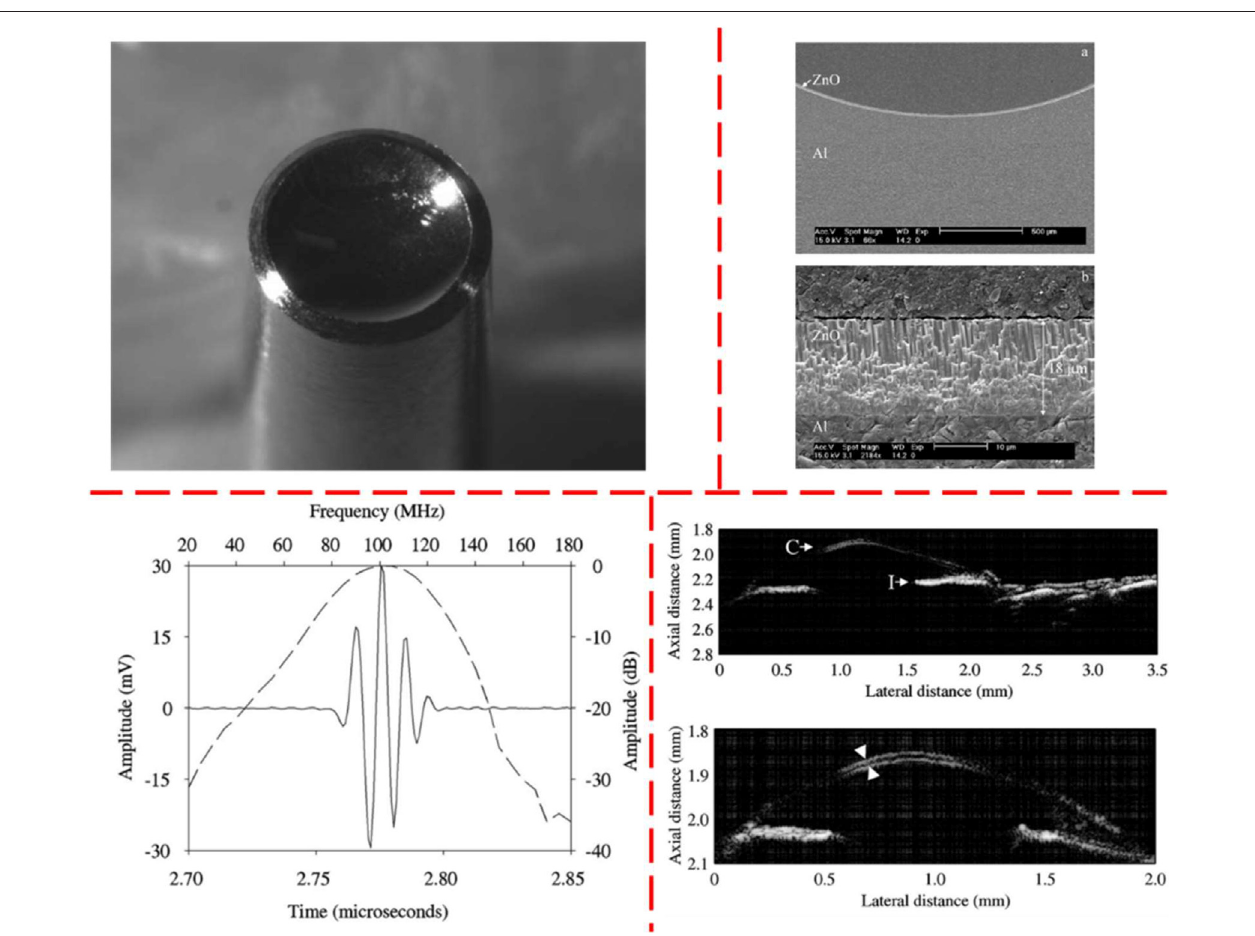
FIGURE 8 | A photograph of 100 MHz ZnO self-focus transducer (top left) ; The SEM cross section of 100 MHz ZnO self-focus transducer (top right) ; time- domainpulse/echoresponse(solidline)andfrequencyspectrum(dashedline)of100 MHzZnOself-focustransducer (bottomleft) ;Highresolutionultrasoundimageof zebra fi sh eye (bottom right) .